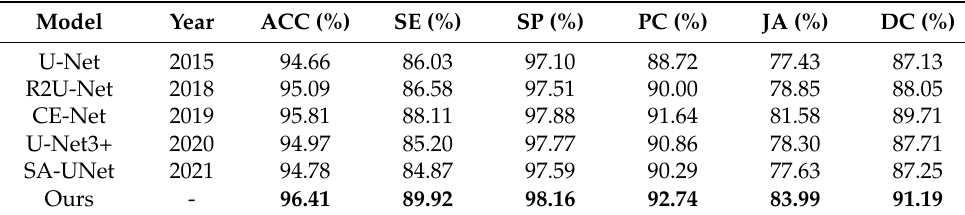
Table 4. Evaluation indicators of each comparative network on ISBI2018.